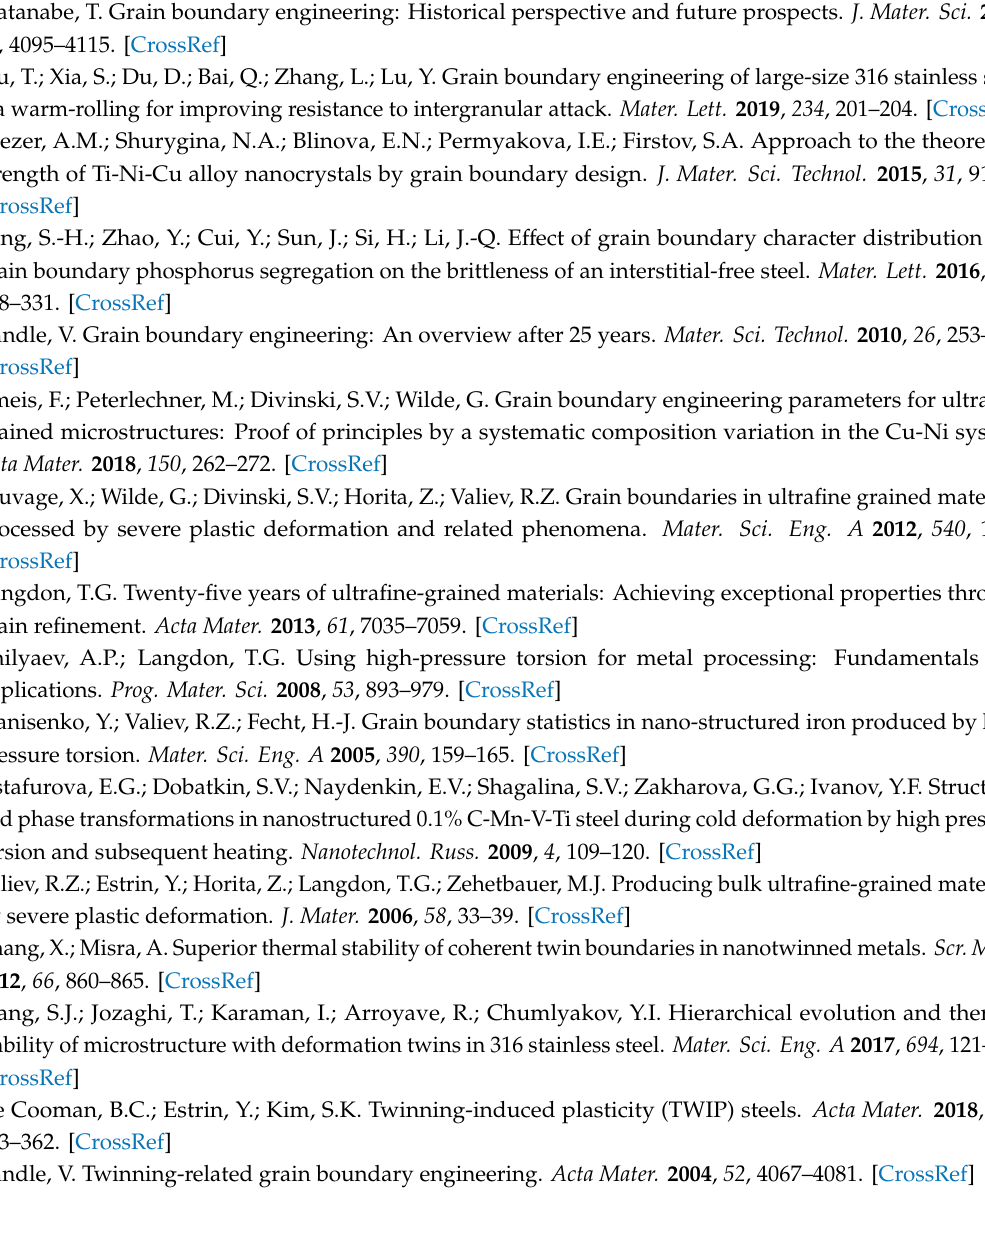
4. A complex e ff ect of the HPT-driven nucleation of the nanoscale precipitates (carbides and ferrite), along with deformation-induced defects (dislocations, twin boundaries, low-angle boundaries, shear bands) in high-temperature deformation provides high microhardness values, which are similar to twin-assisted hardening in cold